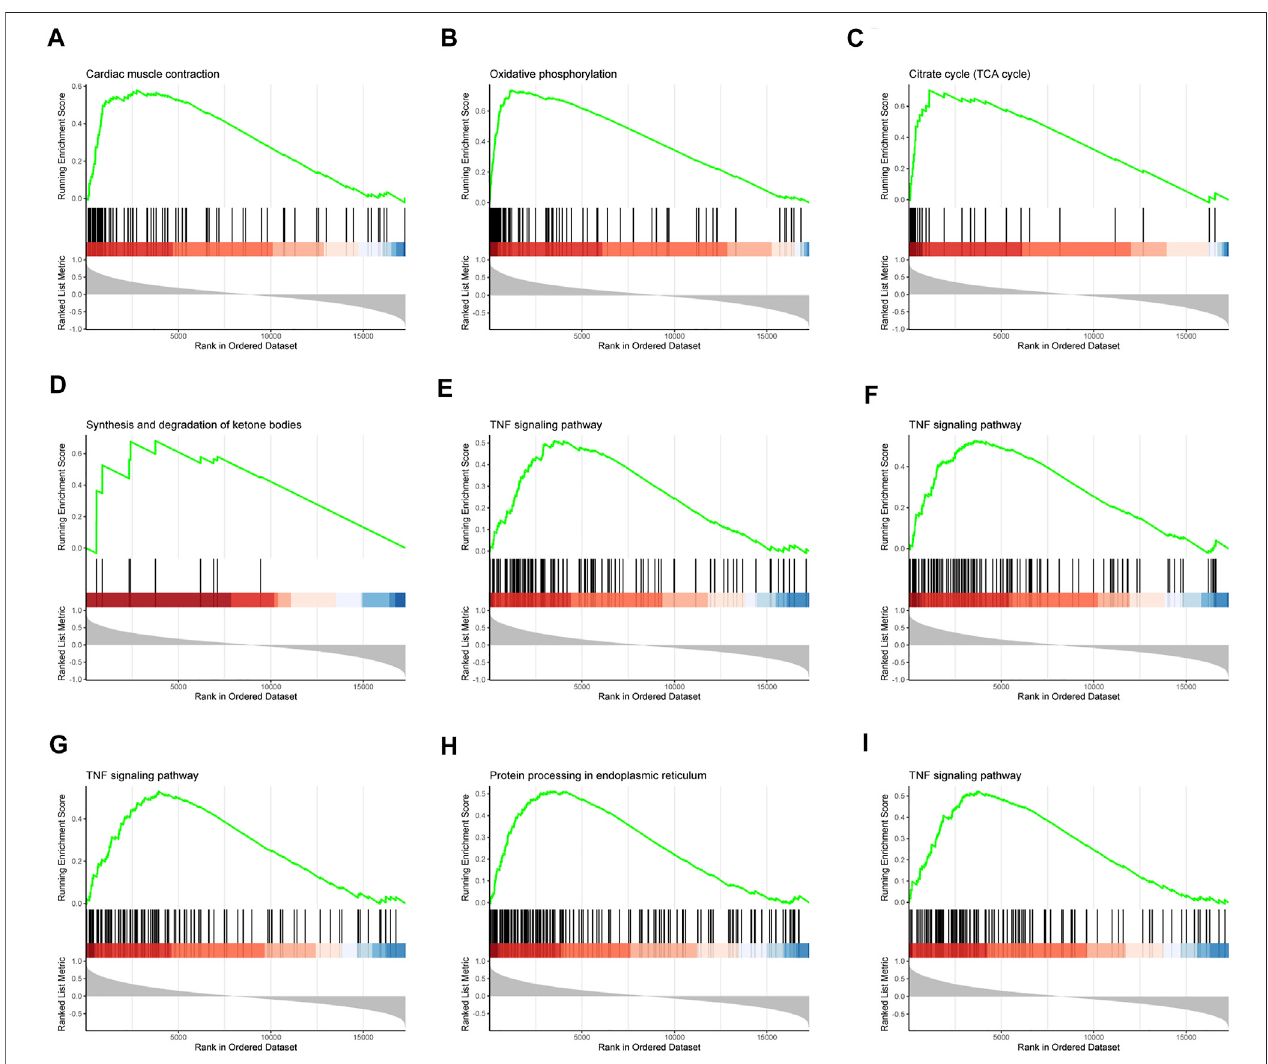
FIGURE 5 | Gene set enrichment analysis (GSEA). The pathway related to hub genes (A) LRRC39 , (B) COQ10A , (C) FSD2 , (D) PPP1R3A , (E) TNFRSF11B , (F) IL1RAP , (G) DGKD , (H) POR , and (I) THBS1 .